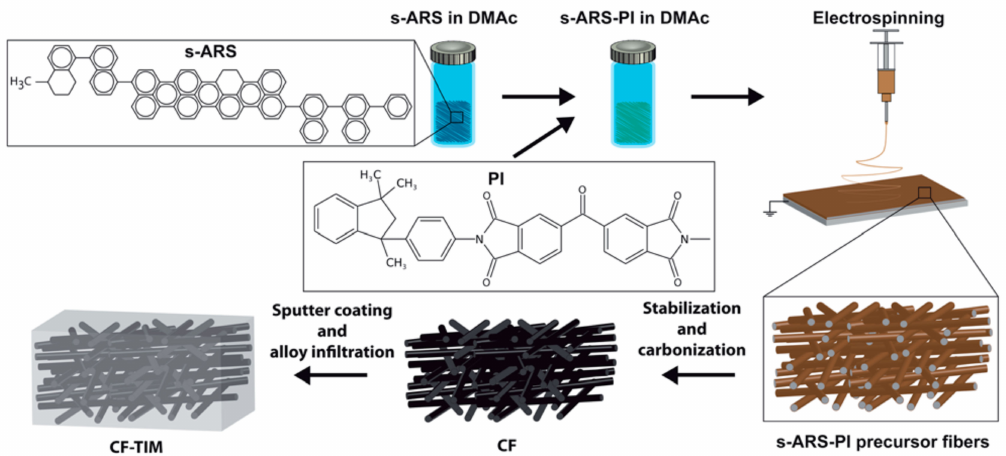
Figure 10. Synthesizing thermal conductive composite using pitch-based CF. Reprinted with permission from [88]. Copy- right The Royal Society of Chemistry